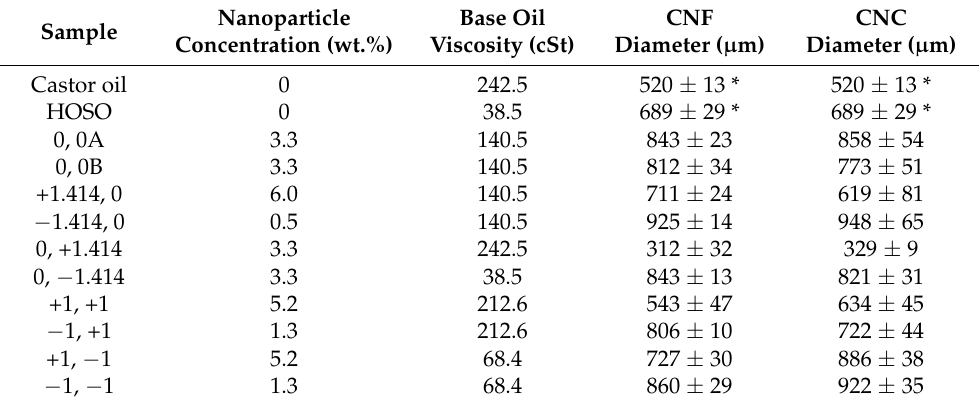
Figure 6. Evolution of friction coefficient with time and wear scars during wear tests at constant sliding velocity of 18.8 mm/s and normal load of 40 N for CNF-based (red curves) and CNC-based (blue curves) ecolubricants. Table 2. Wear scar diameters obtained from wear tests at constant sliding velocity of 18.8 mm/s and normal load of 40 N for both nanocellulose dispersions studied.